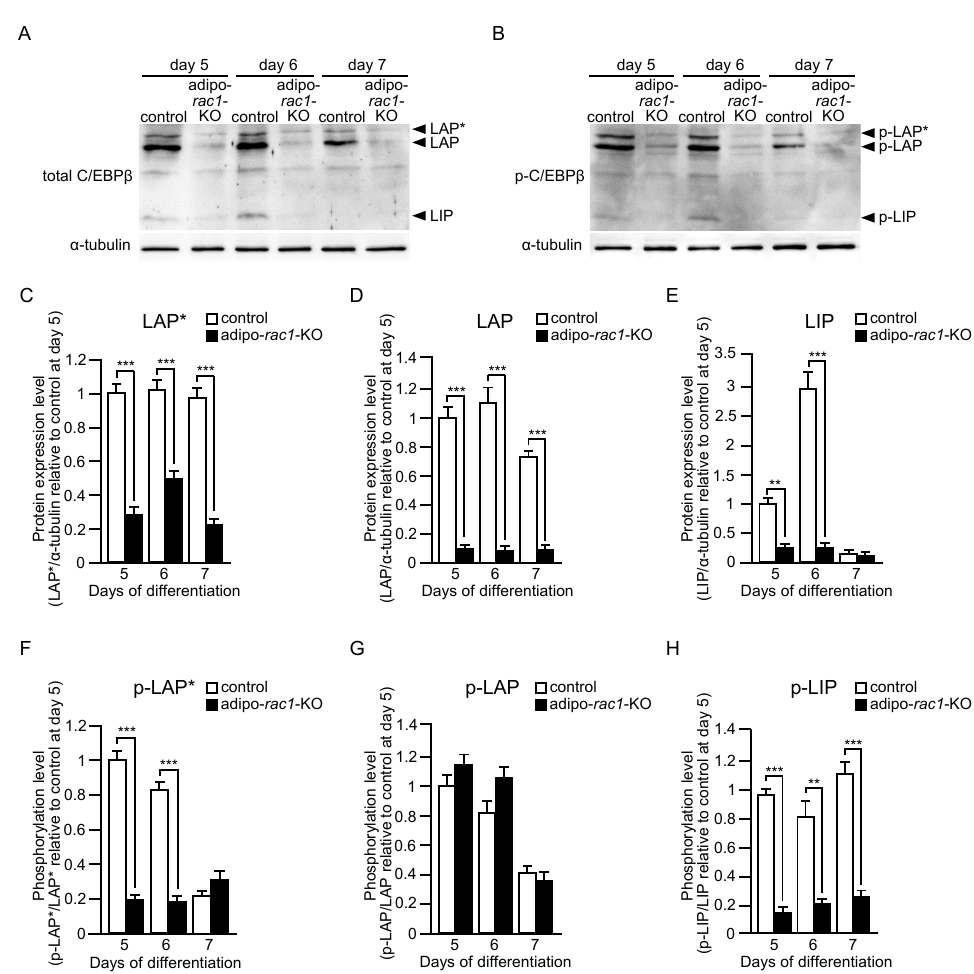
Figure 4. Protein and phosphorylation levels of three C/EBP β variants in the late stage of differentia- tion of adipose progenitor cells into adipocytes in vitro. Protein ( A ) and phosphorylation ( B ) levels of three C/EBP β variants (LAP*, LAP, and LIP) in cells derived from control and adipo- rac1 -KO mice were determined by immunoblot analysis using antibodies against C/EBP β ( A ) and phosphorylated C/EBP β ( B ), respectively. α -tubulin served as a loading control. Intensities of bands for LAP* ( C ), LAP ( D ), LIP ( E ), phosphorylated LAP* (p-LAP*) ( F ), phosphorylated LAP (p-LAP) ( G ), and phos- phorylated LIP (p-LIP) ( H ) in immunoblots were quantified. Data are shown as means ± S.E. ( n = 3). ** p < 0.01, *** p < 0.001 (Student’s t